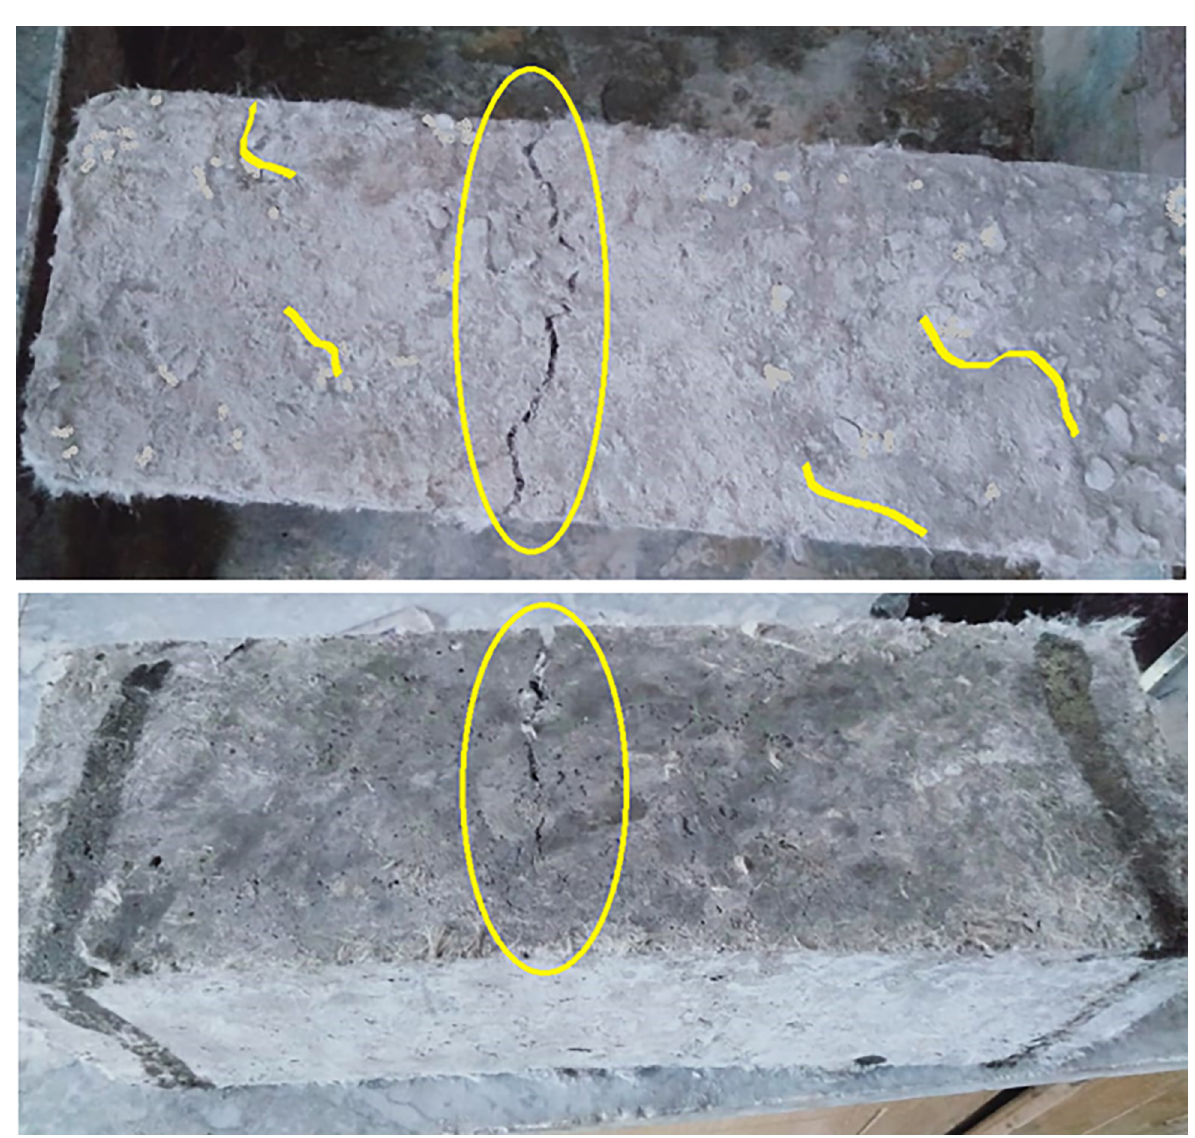
Fig 14. Concrete Sample after flexural test, (a) Control sample, (b) Modified Sample (G3-PPFs-2-NS-10).